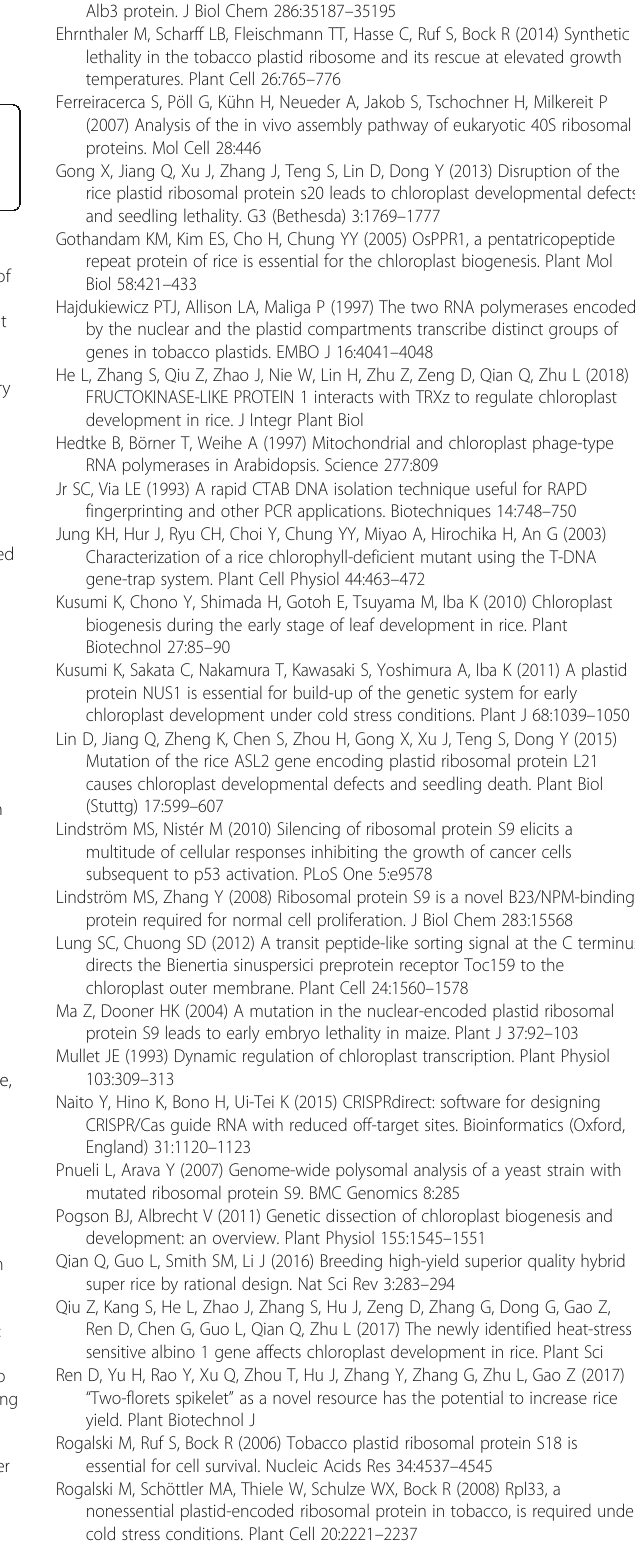
Table S2. The data were expressed as the mean ± SD of three biological replicates. A Student ’ s t -test was used for statistical